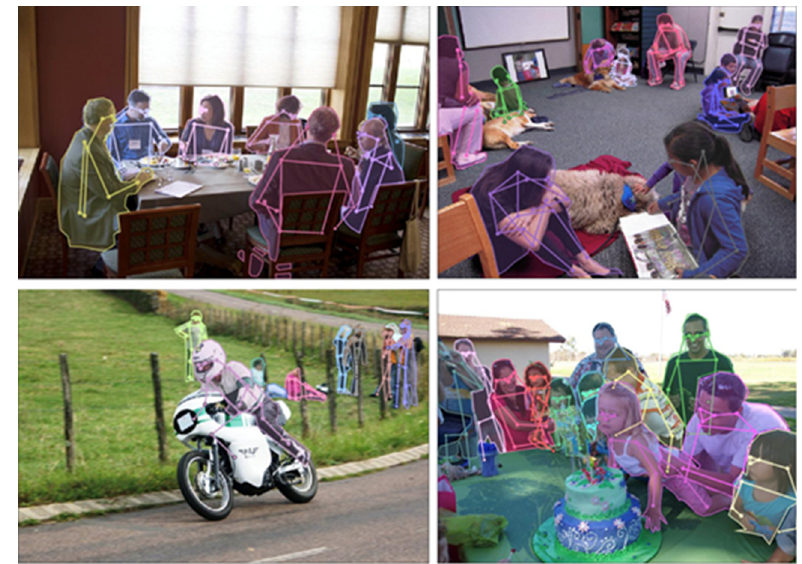
Figure 12. Demonstrations of Common Objects in Context (COCO) Keypoint Dataset